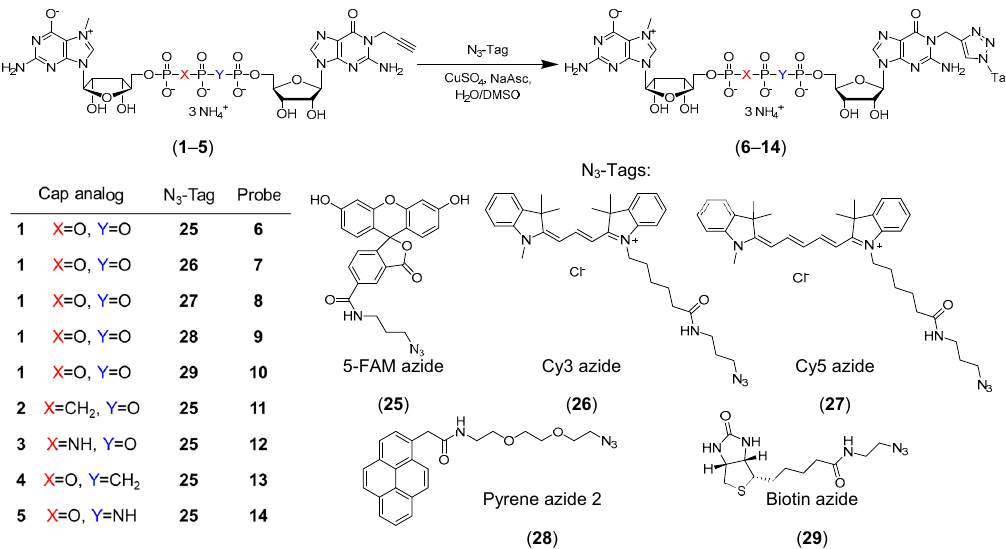
Figure 1. Synthesis of N1 functionalized dinucleotides ( 6 – 14 ) from N1-propargylated cap precursors ( 1 – 5 ) via a CuAAC reaction.